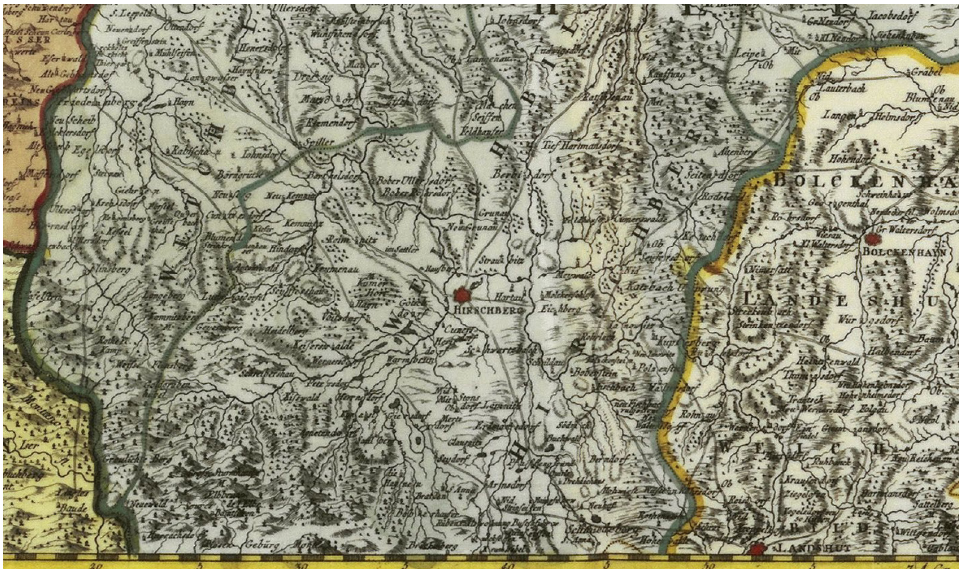
Fig. 2. Vicinity of Jelenia Góra on the map of J.W. Jäger’s great atlas of Germany from 1789. Relief presented with three methods: hillocks, semi-perspective and simple hachure (source: www.kartensammlung